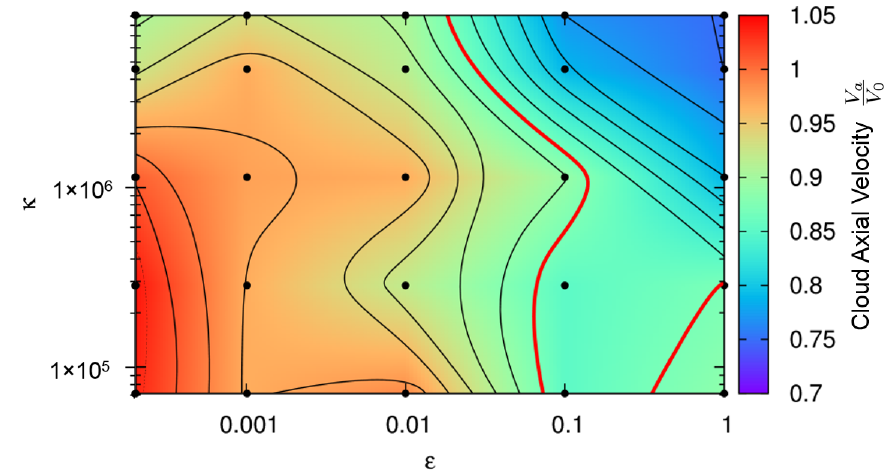
Figure 10. Contour plot representing the debris cloud’s axial expansion velocity normalized by the impact velocity. Color code refers to the velocity v a / v 0 shown on the right side of the figure. The experimentally measured value is shown as a red contour line. See main text for details.